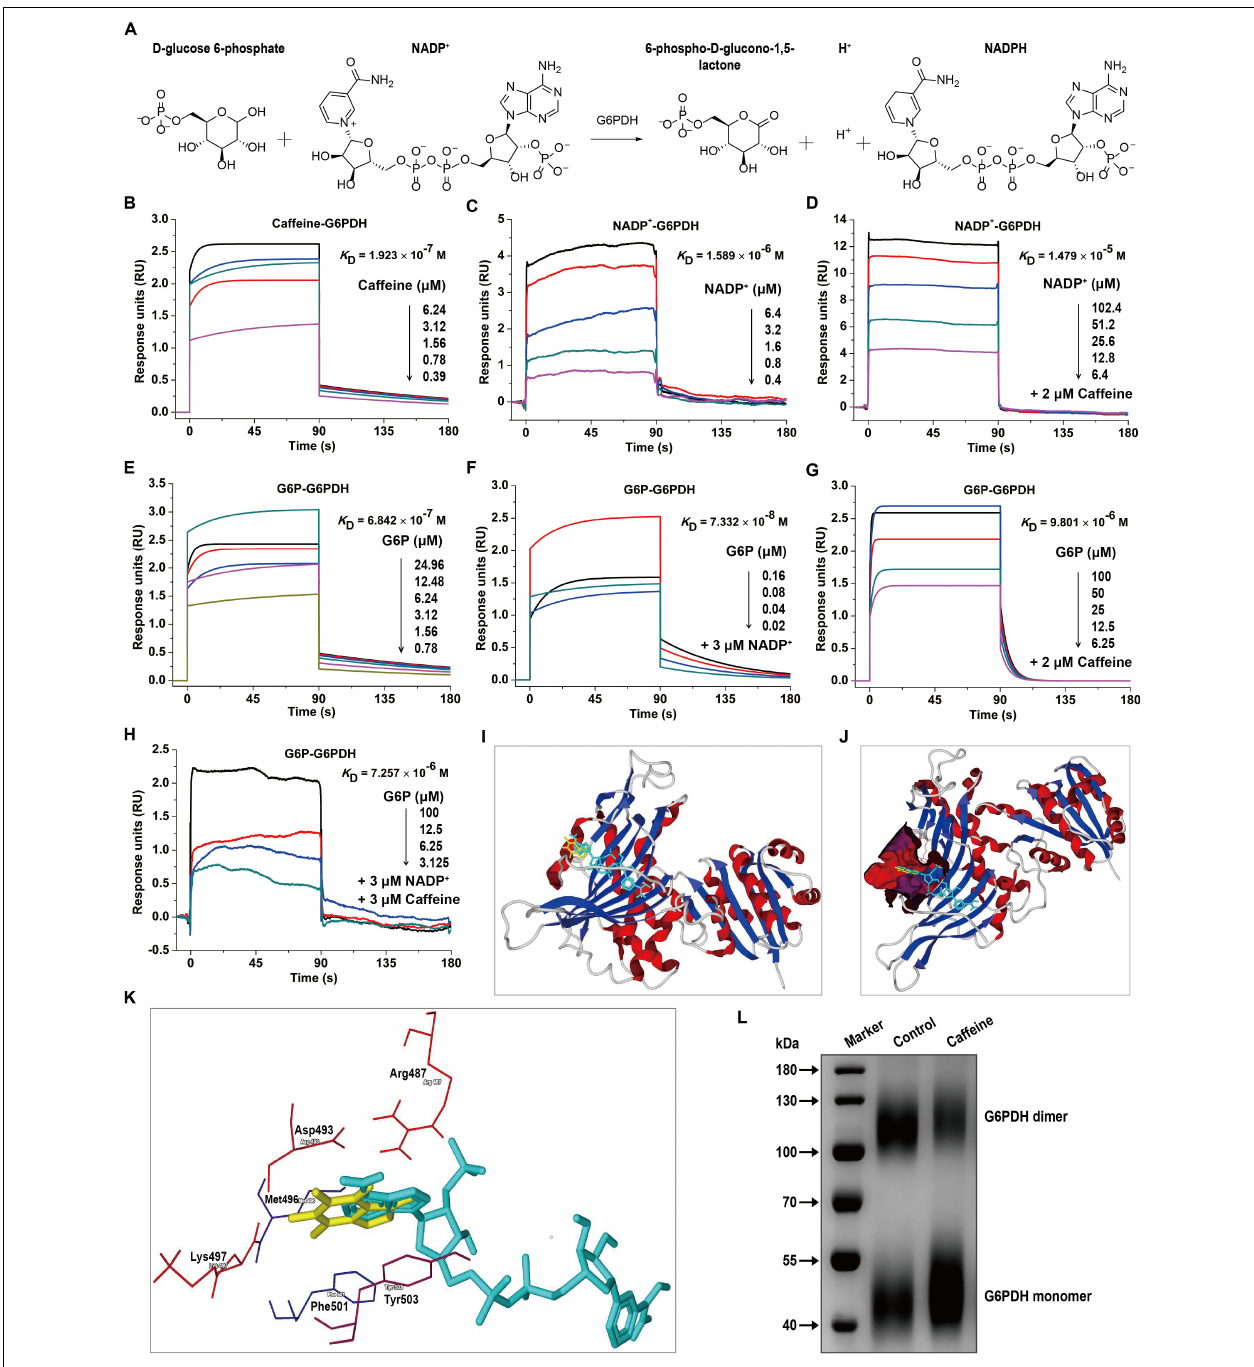
FIGURE 2 | Caffeine directly binds to G6PDH and decreases its coenzyme and substrate binding affinities. (A) The enzymatic reaction process involving G6PDH. (B) Caffeine directly binds to G6PDH, with a binding affinity of K D = 1.923 × 10 - 7 M. (C) The coenzyme NADP + binds to G6PDH, with K D = 1.589 × 10 - 6 M. (D) NADP + binds to G6PDH in the presence of caffeine (2 µ M), with K D = 1.479 × 10 - 5 M. (E) The substrate G6P binds to G6PDH, with K D = 6.842 × 10 - 7 M. (F) G6P binds to G6PDH in the presence of NADP + (3 µ M), with K D = 7.332 × 10 - 8 M. (G) G6P binds to G6PDH in the presence of caffeine (2 µ M), with K D = 9.801 × 10 - 6 M. (H) G6P binds to G6PDH in the presence of NADP + (3 µ M) and caffeine (3 µ M), with K D = 7.257 × 10 - 6 M. (I–K) The computational binding mode of caffeine to human G6PDH (PDB code: 2BH9) was established using the MVD molecular docking software. (I) Caffeine (yellow) binds to G6PDH (ribbon) at the structural NADP + (light blue) binding site. (J) Caffeine (yellow) and NADP + (light blue) are both bound in the same pocket (magenta) of G6PDH (ribbon). (K) The binding pocket for caffeine (yellow) and NADP + (light blue) is formed by six important residues in G6PDH, shown in sticks: Arg487, Asp493, Met496, Lys497, Phe501, and Tyr503. (L) Caffeine inhibits the formation of dimeric G6PDH, as demonstrated by chemical cross-linking analysis. All SPR experiments were performed using a Biacore S200 instrument. The data displayed here represent one of three independent experiments with similar results.